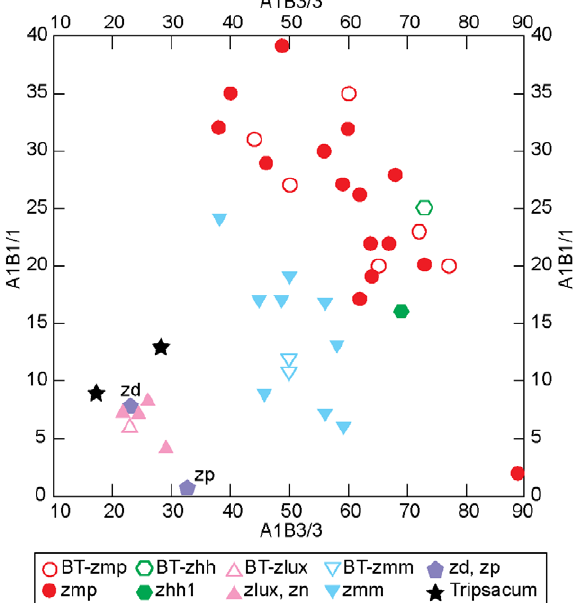
Figure 5. Teosinte samples plotted against abundance of rondel classes A1B3/3 and A1B1/1. Samples coded as in Figure 4.